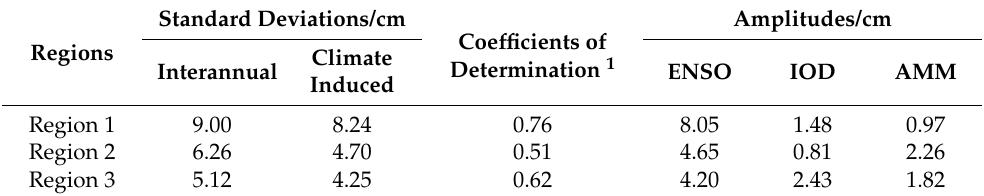
Table 1. Statistics of interannual and climate-induced TWS changes in the three selected regions.